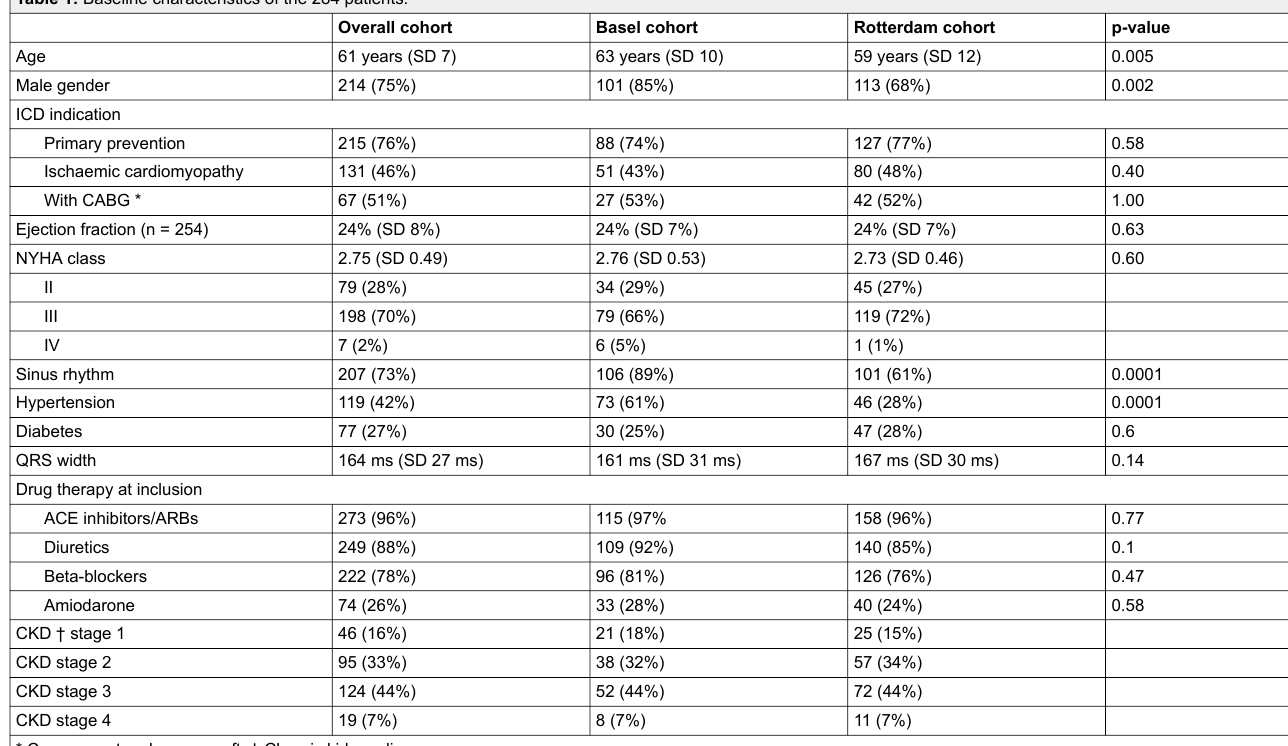
Table 1: Baseline characteristics of the 284